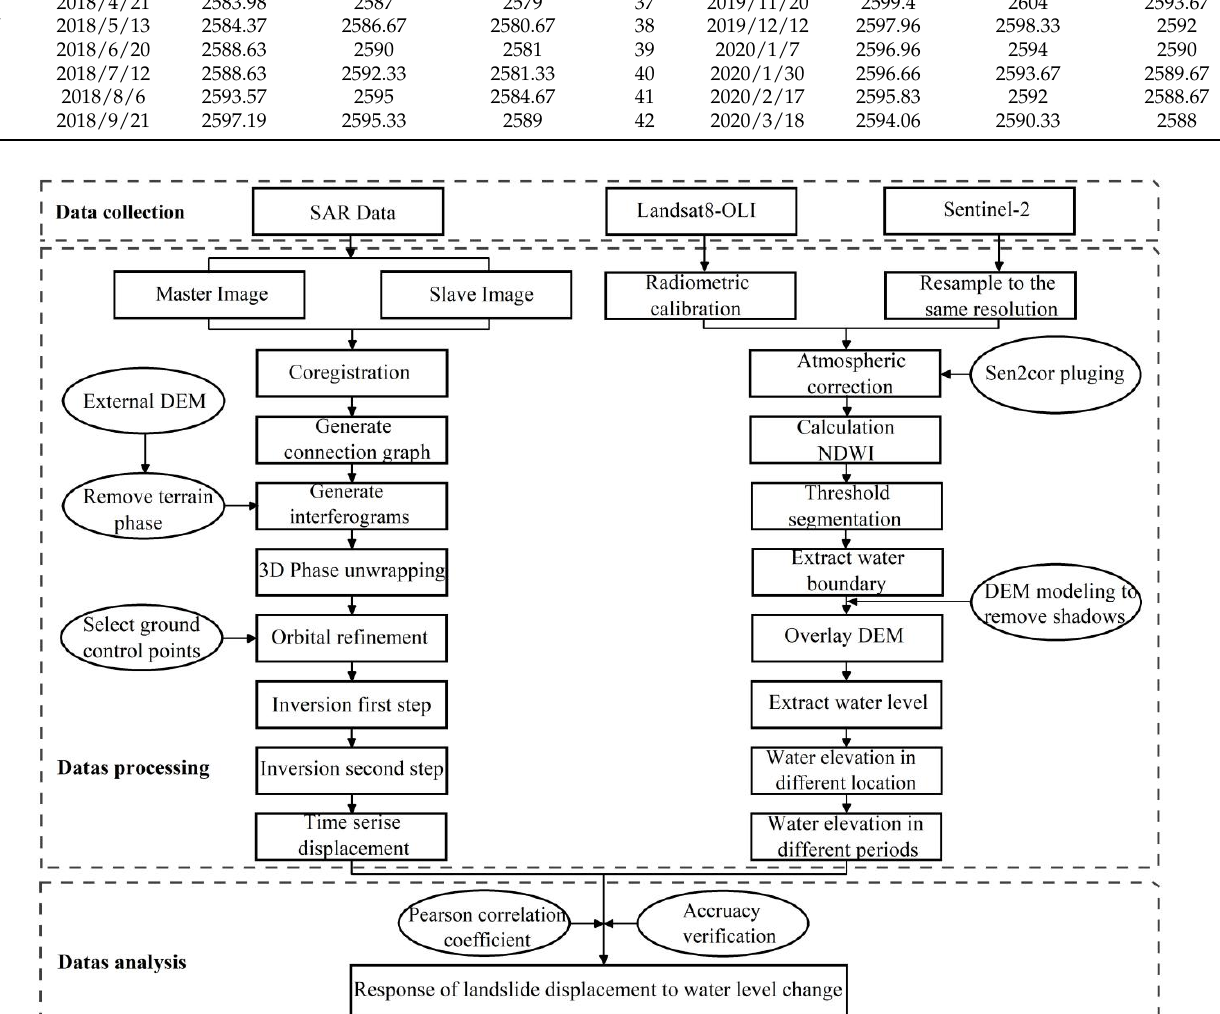
Figure 7. Flow chart of the application of SBAS-InSAR technology and water level extraction.